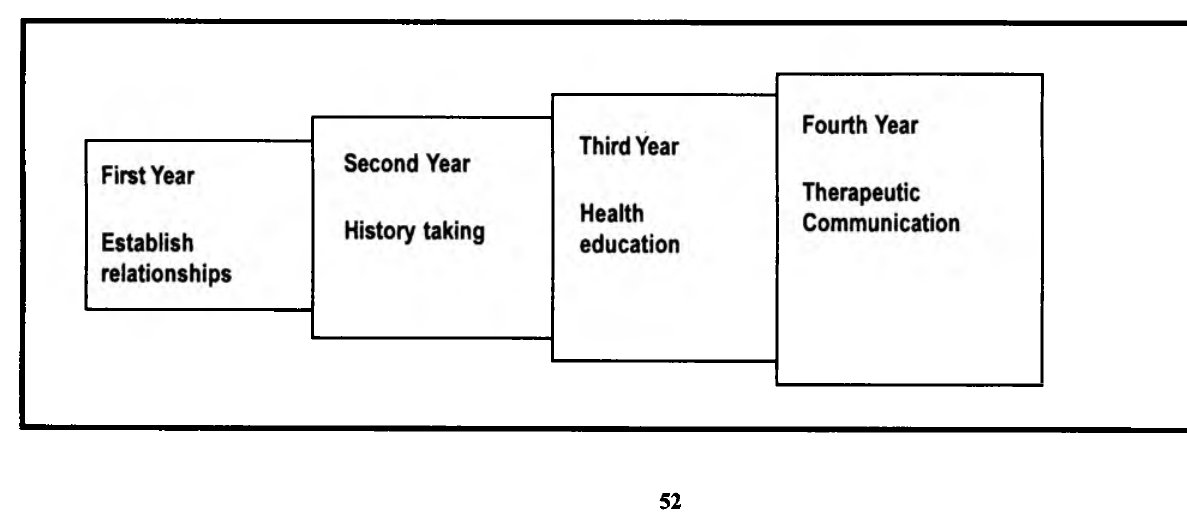
Figure (i): Alignment of Competency: